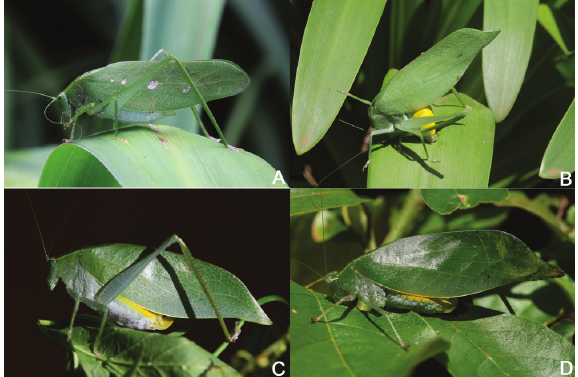
Figure 2. Habitus of Gonatoxia species. A, B. Male ( A ) and female ( B ) of G. maculata , Rau forest Kilimanjaro. Male with maculae on tegmina, female ( B ) showing the bright yellow terg- ites of abdomen, typical for all Gonatoxia species. C. Female G. immaculata , Kazimzumbwi Forest Reserve, Kisarawe near Dar es Salaam D. Female G. furcata sp. n., lowland forest Udzungwa Mountains, Morogoro District,